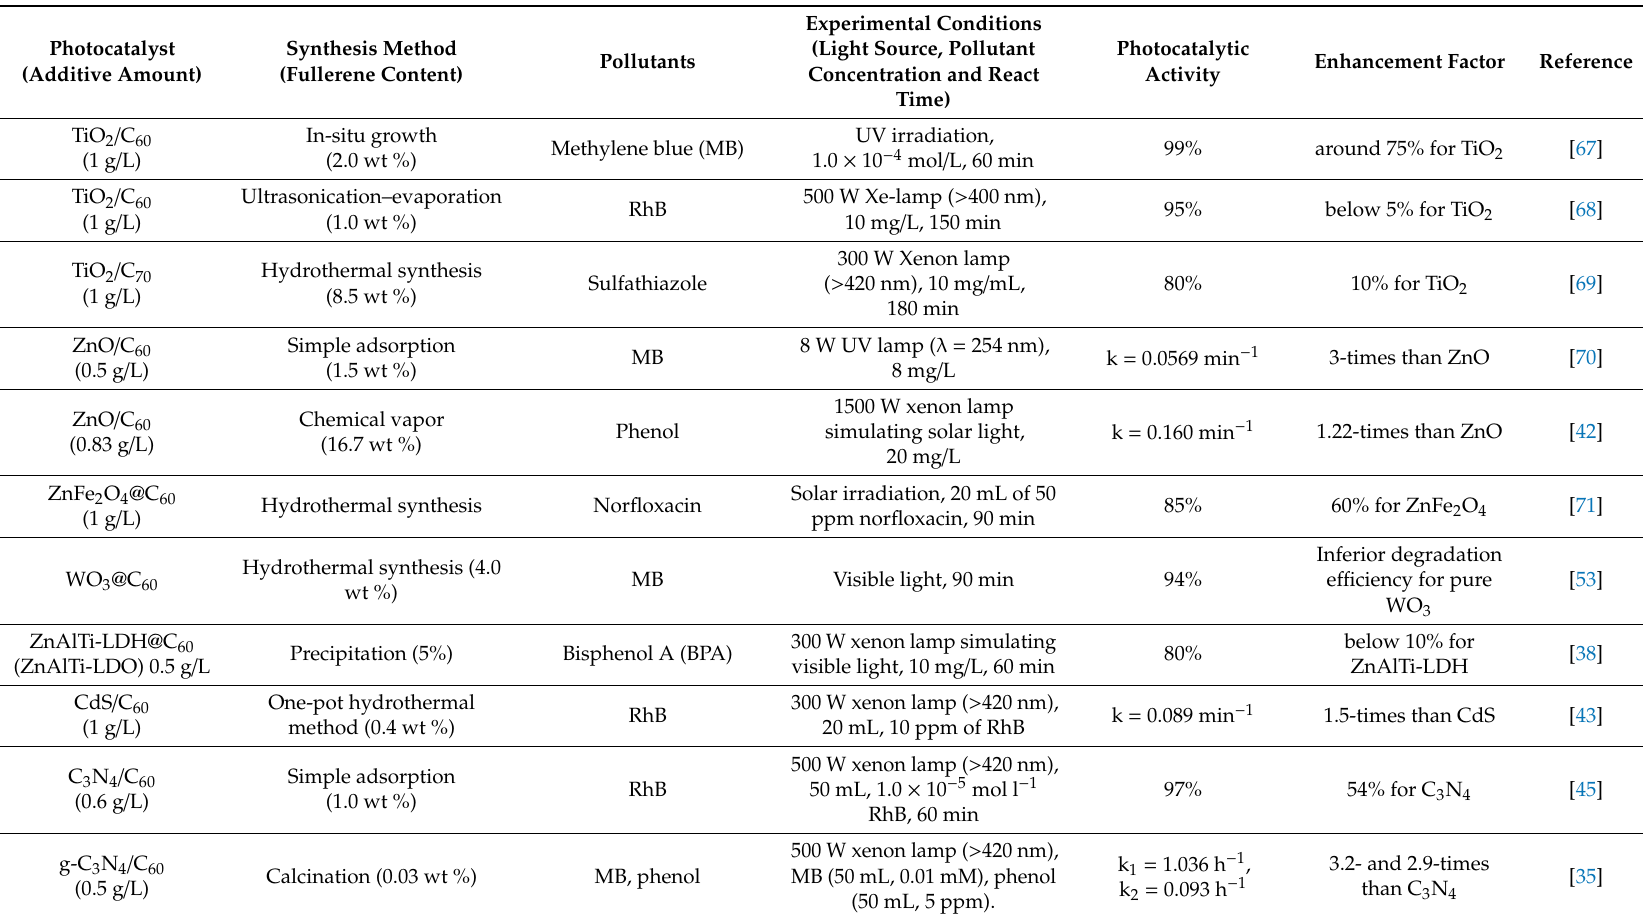
Table 1. Summary of fullerene based photocatalysts for pollutant